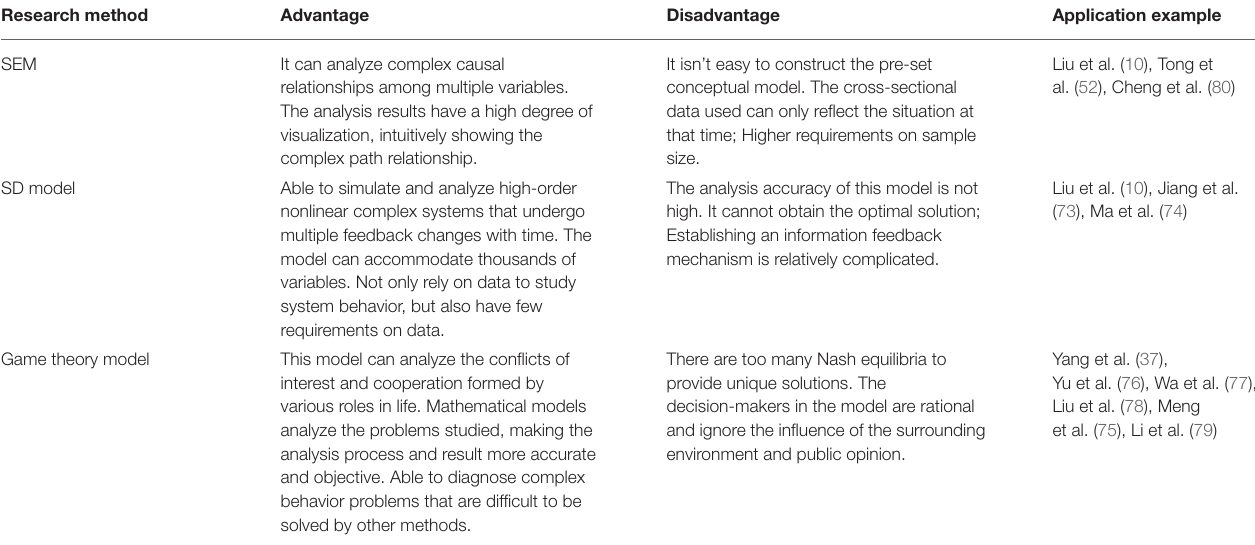
TABLE 7 | The advantages and disadvantages of the main research methods on the formation mechanism of unsafe behavior of miners. Research method Advantage Disadvantage Application example